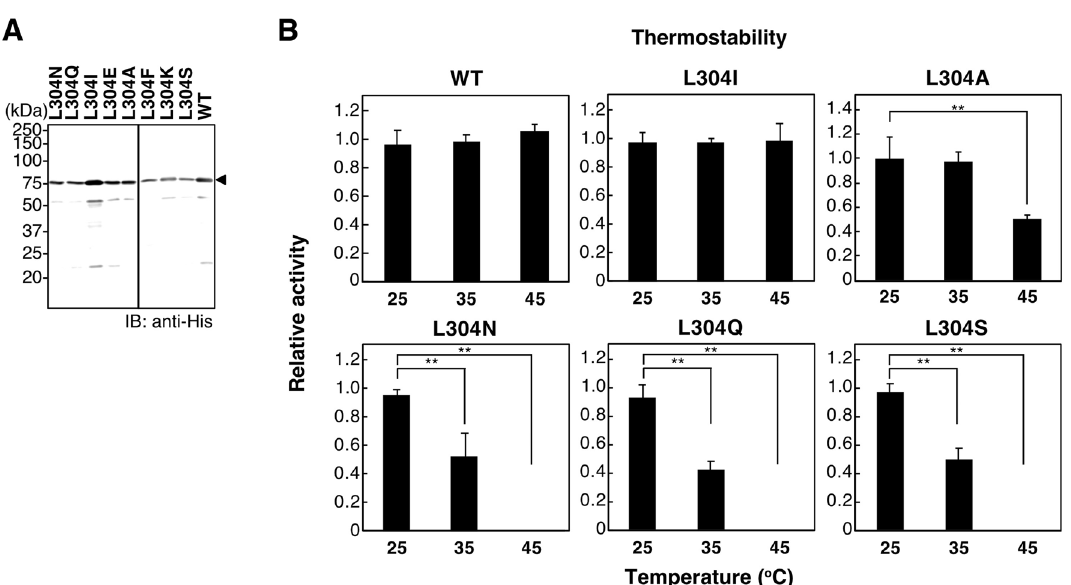
Figure 7. In vitro properties of the single amino acid-substituted mutants at L304. ( A ) Western blotting of the recombinant mdkCSS mutants, L304N, L304Q, l304I, L304E, L304A, L304F, L304K, L304S, and WT with the anti-His antibody. The soluble forms were obtained from all the recombinant proteins expressed in E. coli . Full- length blots for A are presented in Supp_FigS14. ( B ) Thermostability of the L-304 mutants and WT of mdkCSS. Recombinant CSS proteins were pre-heated at 25, 35, or 45 °C for 15 min and measured for in vitro CSS activity. Relative in vitro activity of CSS was obtained as the amount of produced CMP-Neu5Ac divided by the intensity of the recombinant protein, and the value for mdkCSS without pre-heating ( i.e. , 25 °C) was set to 1.0. The bars represent standard deviations from three independent experiments. **indicates p <